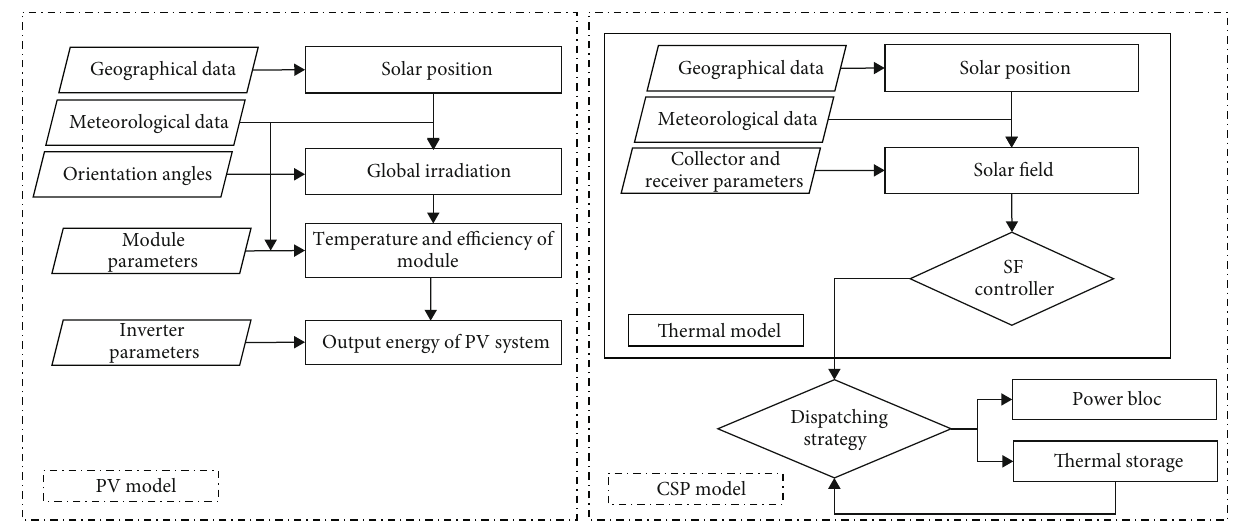
Figure 2: Model of PV and CSP plants.